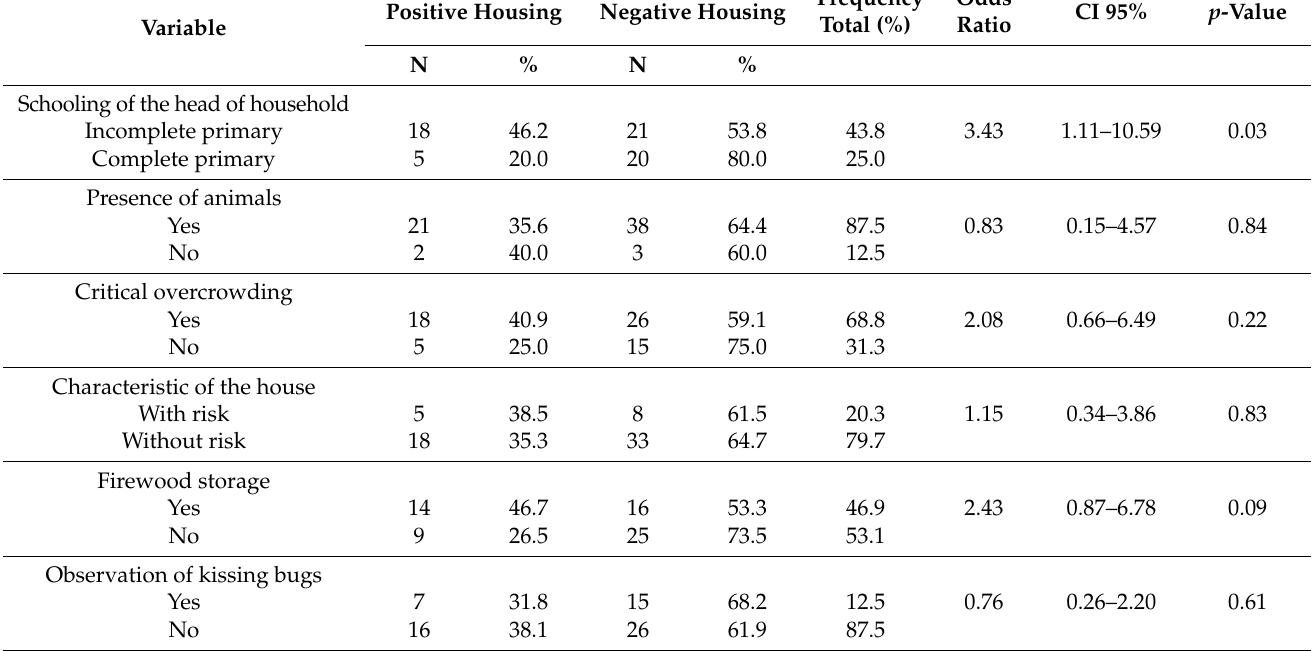
Table 3. Frequency of the head of household’s level of schooling and housing variables, and their association with positive housing. Indigenous communities of the southern Chaco